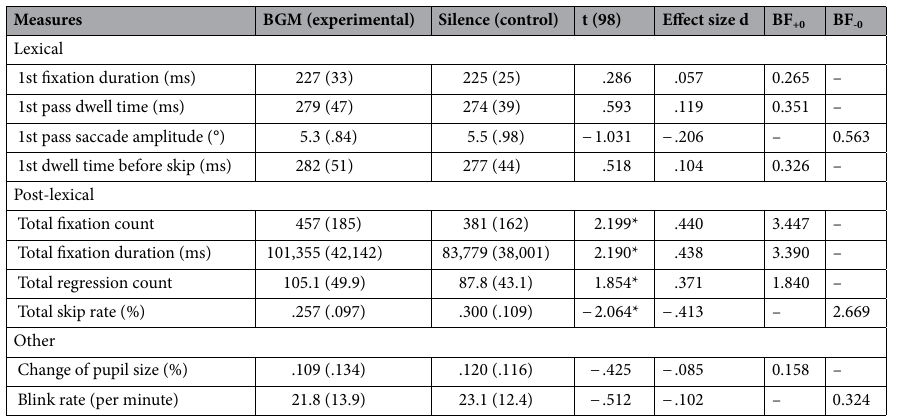
Table 5. Results of T-tests on eye movement behaviors. N = 100 (BGM Group = 50; Silence Group = 50). * p values < 0.05 were at significant level.